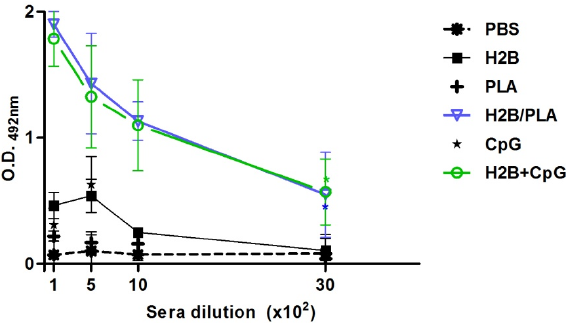
Figure 5. Specific anti-H2B antibody immune response. Pooled sera from each group were reacted in ELISA with recombinant H2B protein. Total IgG titers were calculated for each group. Titers were scored positively at the last dilution of immune sera. Results are represented as mean ± standard deviation of optical density (O.D.). (*) p < 0.05 between PBS control and protein-received groups.